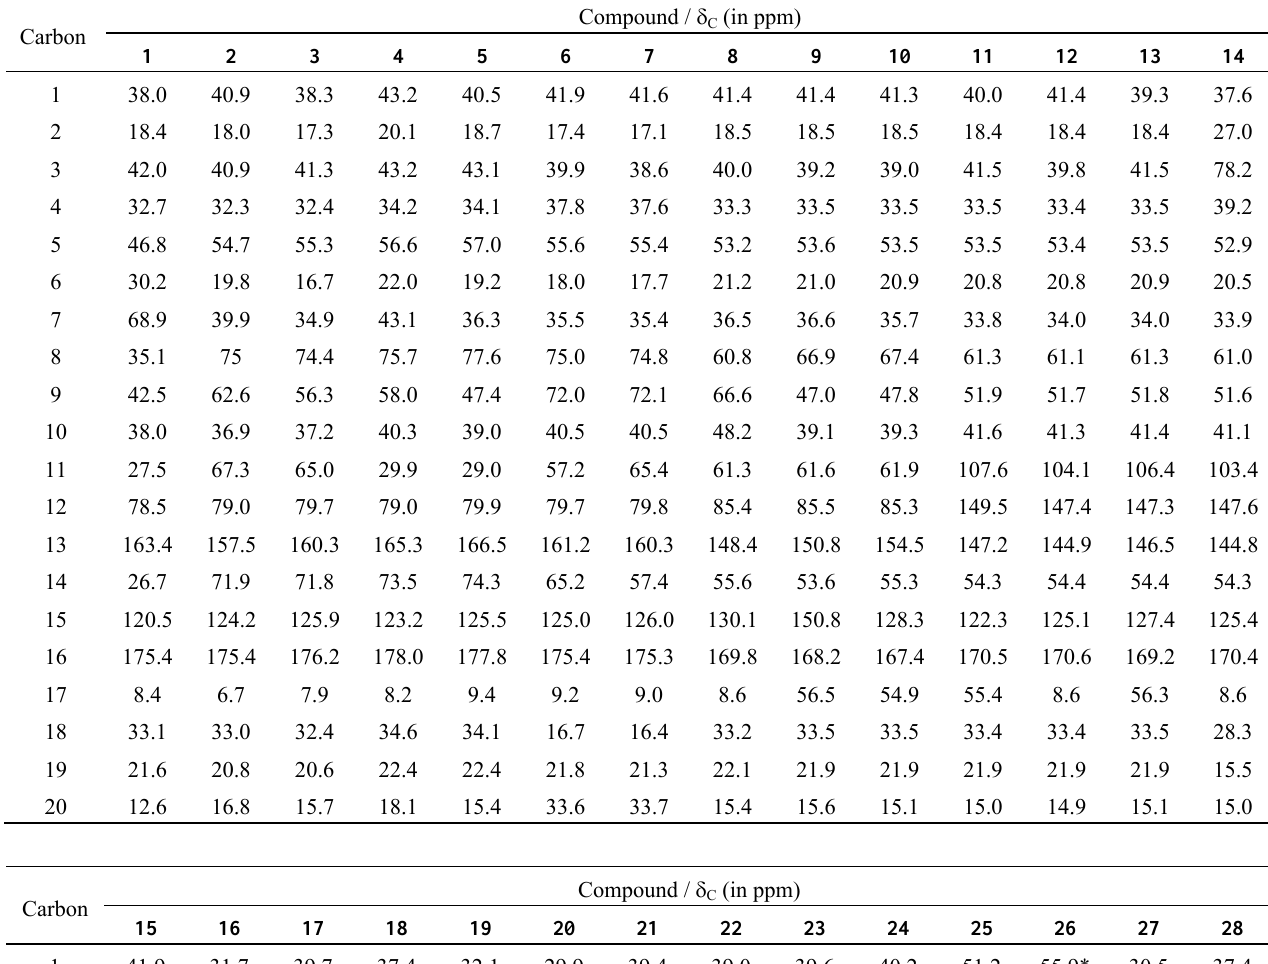
) of diterpenes from Euphorbia 3